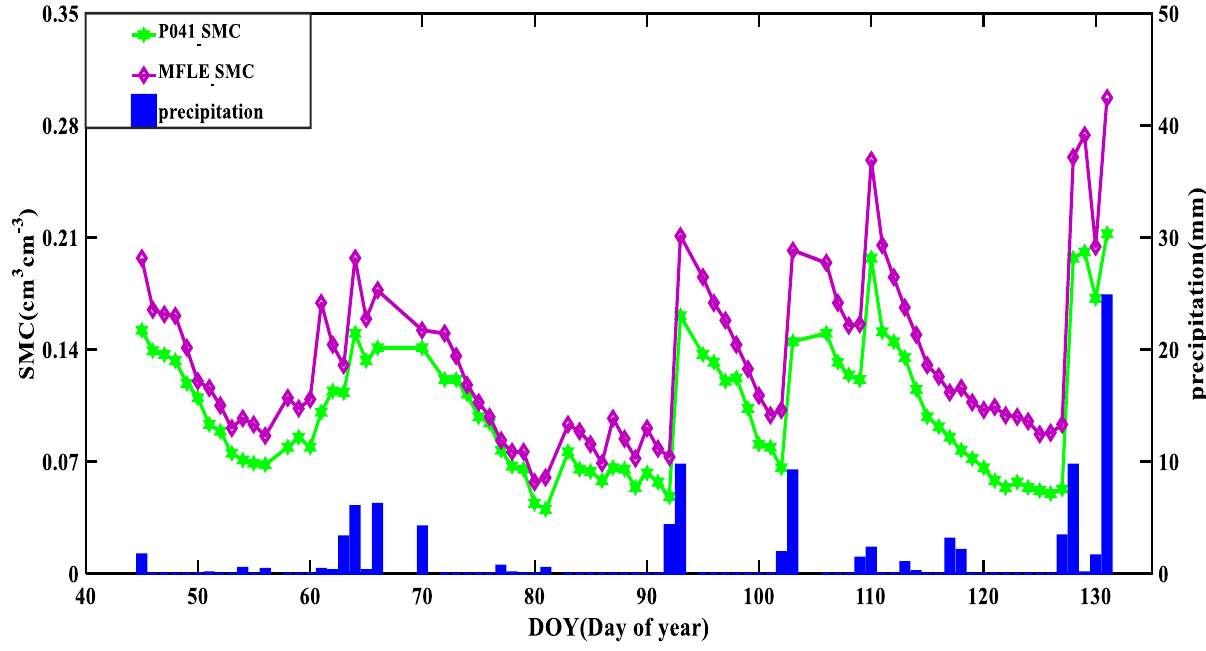
Figure 4. The soil moisture rainfall diagram during the experimental